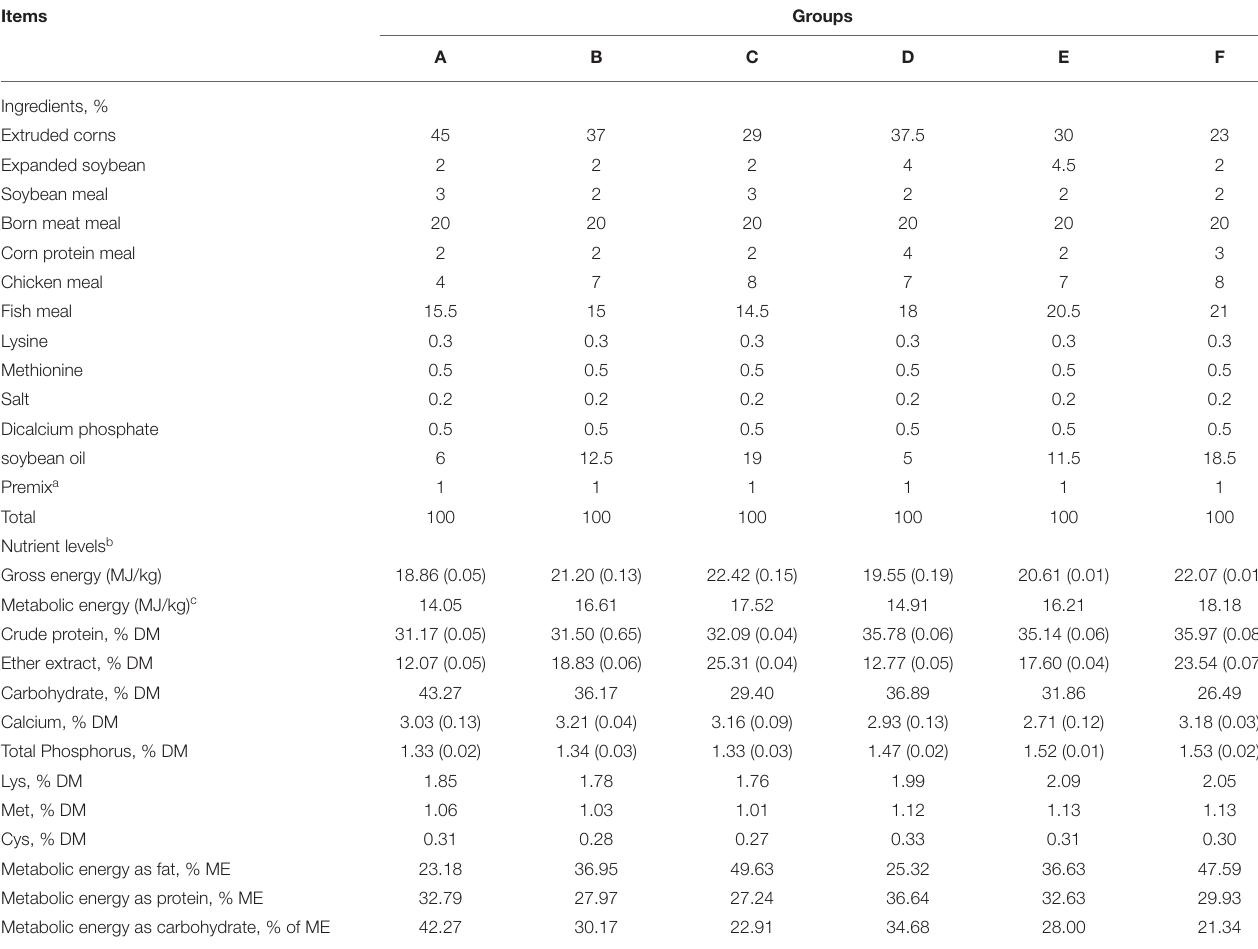
TABLE 2 | Composition and nutrient level of experiment diet (%; air-dry